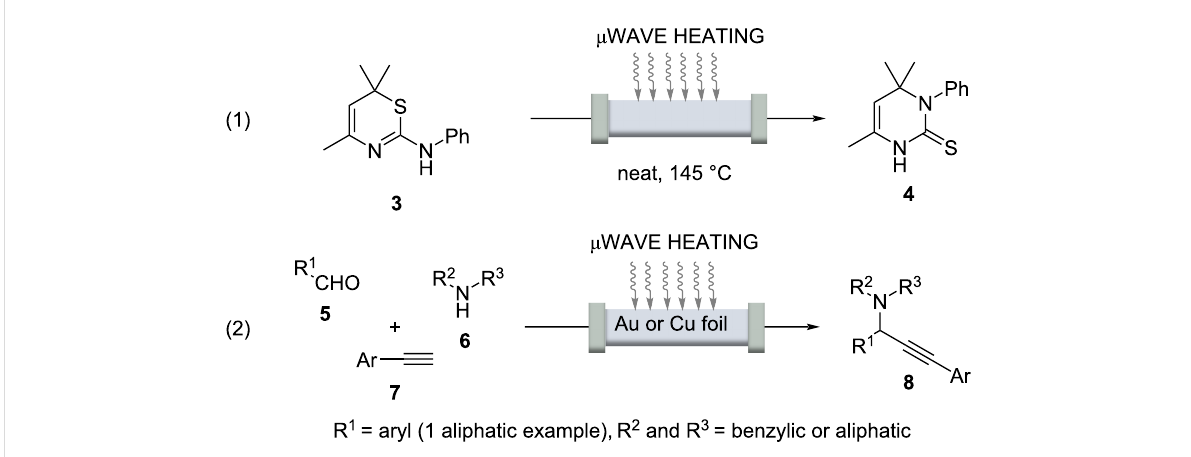
(Scheme 7, reaction 2). Microwave irradiation interacted with a thin foil of Cu or Au that served as catalyst inside the glass capillary. The work must be highlighted in that the actual tem- perature of the glass/metal surface could be determined locally using a high-resolution IR camera. It was found to be 950 °C and not 185 °C of the reaction mixture itself. These studies are